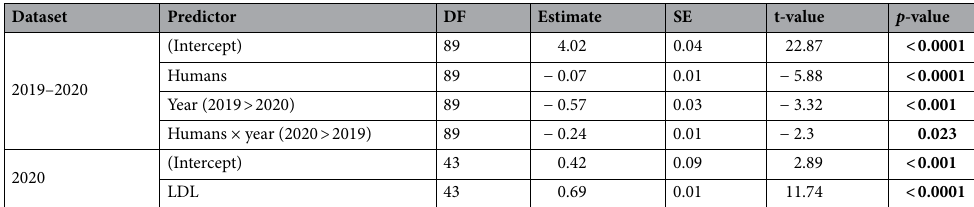
Table 1. Mixed effects model outputs testing effects of human abundance, year and lockdown level (LDL) on shorebird abundance over a 2-year period (2019 and 2020) in Muizenberg beach. An interaction between year and human abundance is included in the model for the 2019 and 2020 data. LDL results are specific to the 2020 dataset only. Significant p -values are shown in bold. ‘Season’ and ‘week’ were included as random factors in both models.